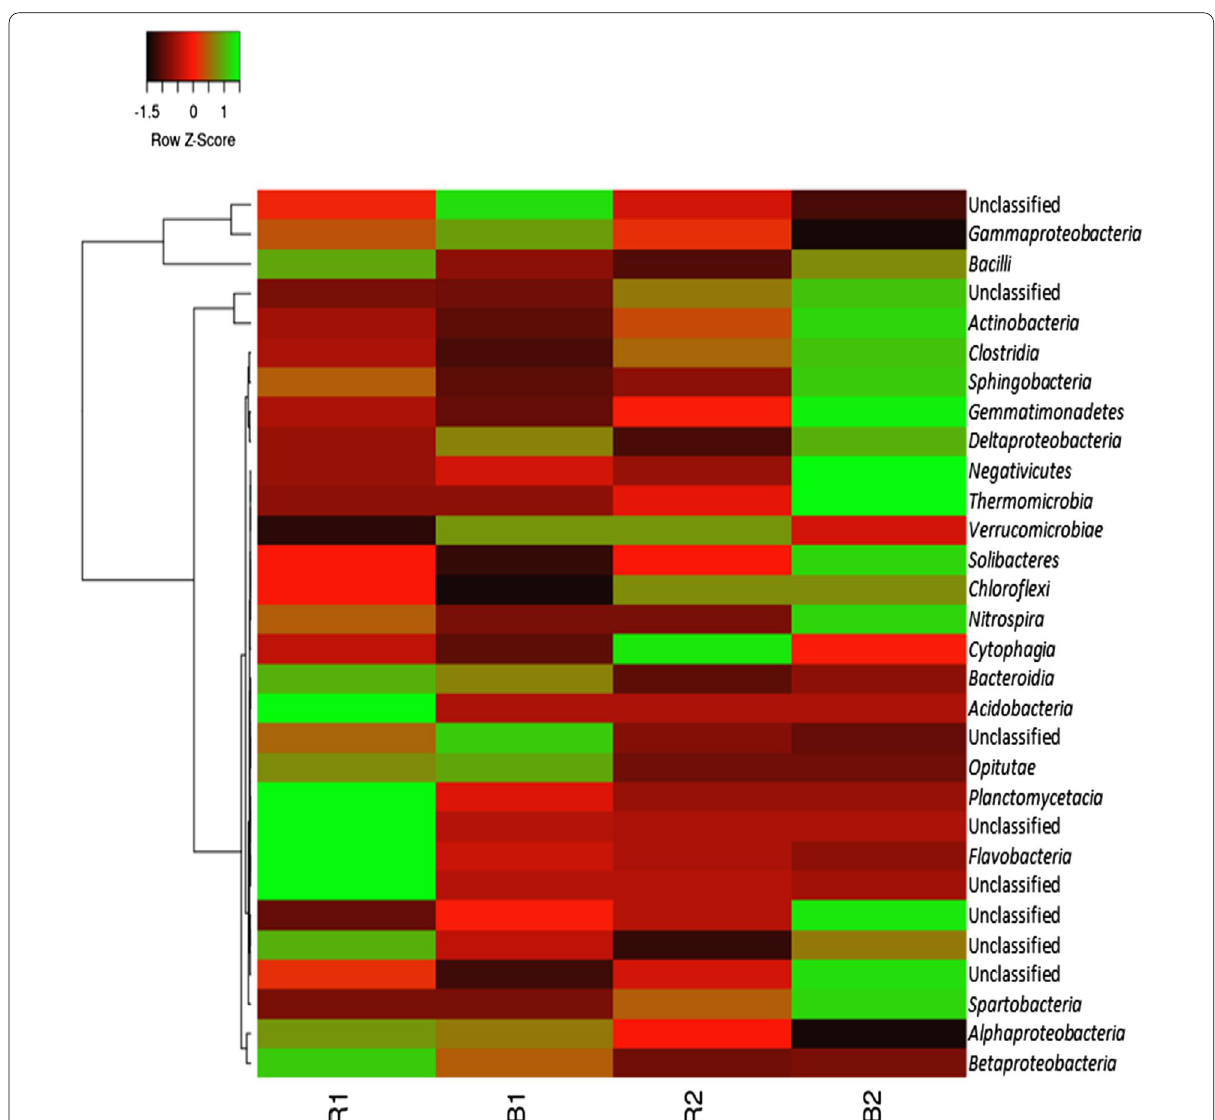
Fig. 3 A heat-map of the bacterial taxonomic structure and relative abundance at class level from sunflower rhizosphere and bulk soils. The scale bar signifies colour saturation gradient established by the relative abundances with z-score. Bacterial groups with more intense color have higher relative abundant values. R1 Ditsobottla rhizosphere soil; B1 Ditsobottla bulk soil; R2 Kraaipan rhizosphere soil; B2 Kraaipan bulk